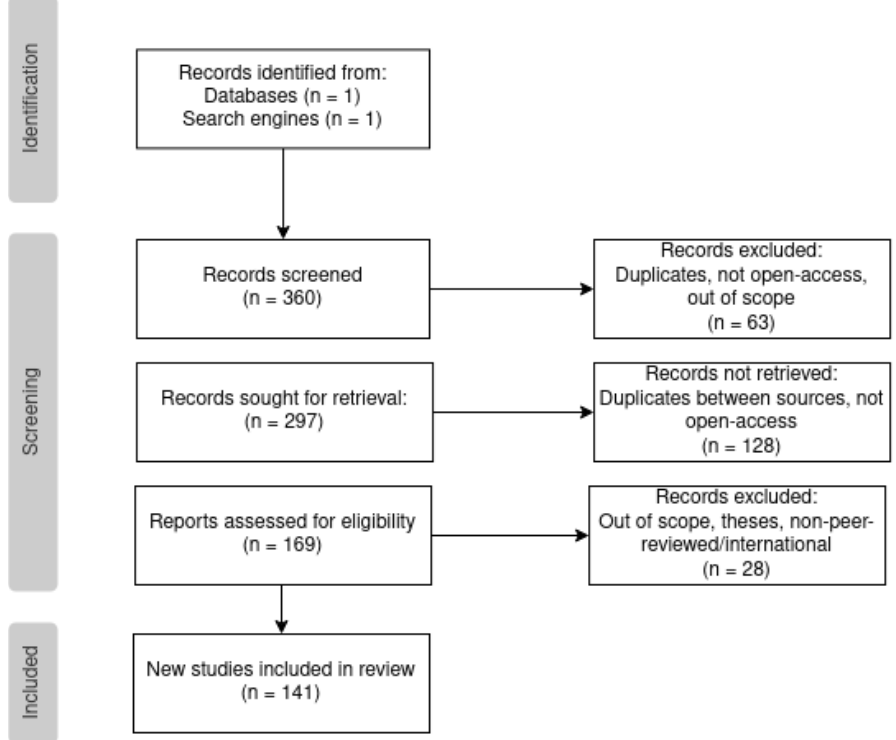
Figure 2. PRISMA flowchart with the steps taken to reach the final list of articles for